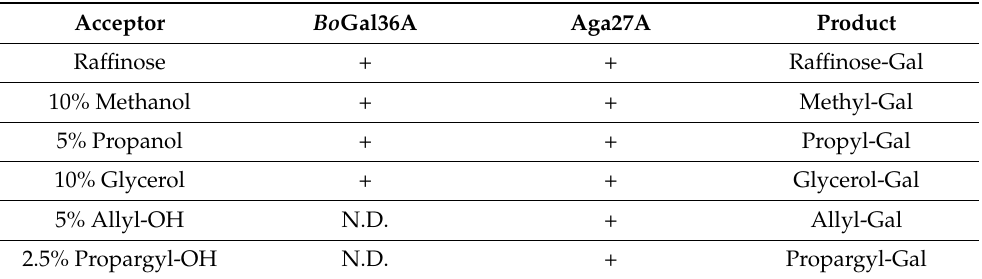
Table 2. Screening of transglycosylation products from incubations with raffinose as donor and different acceptors with Bo Gal36A and Aga27A. N.D., not detected. Acceptor Bo Gal36A Aga27A Product Raffinose + + Raffinose-Gal 10% Methanol + + Methyl-Gal 5% Propanol + + Propyl-Gal 10% Glycerol + + Glycerol-Gal 5% Allyl-OH N.D. + Allyl-Gal 2.5% Propargyl-OH N.D. + Propargyl-Gal